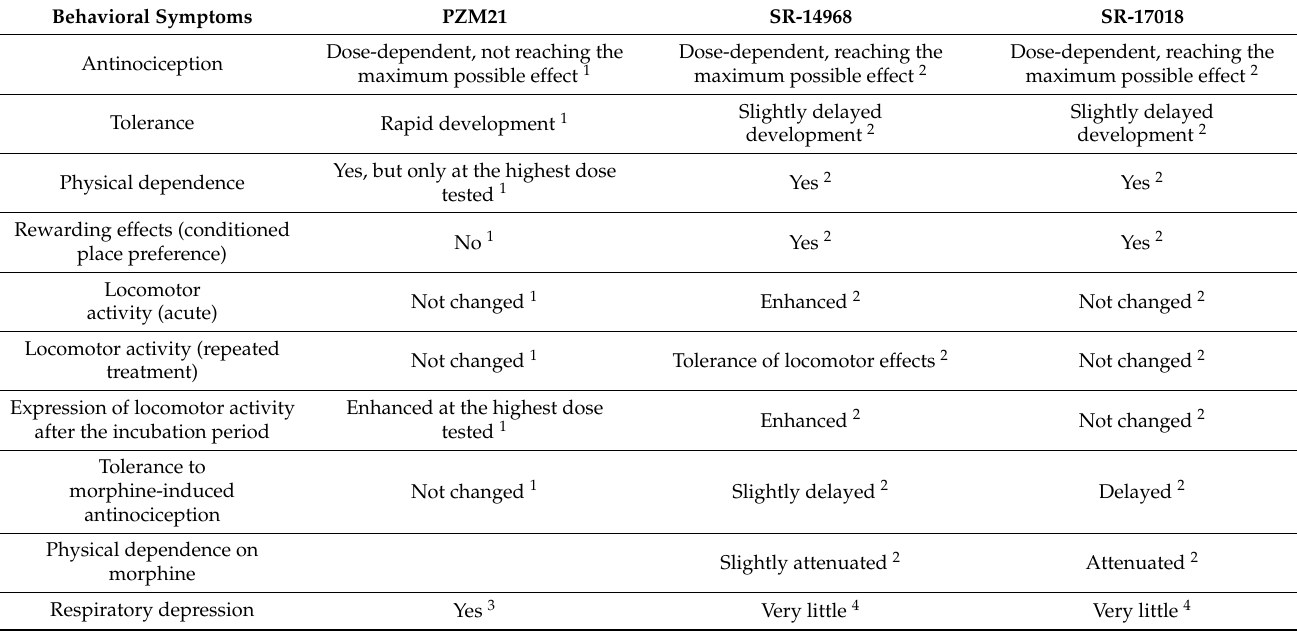
Table 1. Comparison of the effects of PZM21 and SR agonists on addition-like